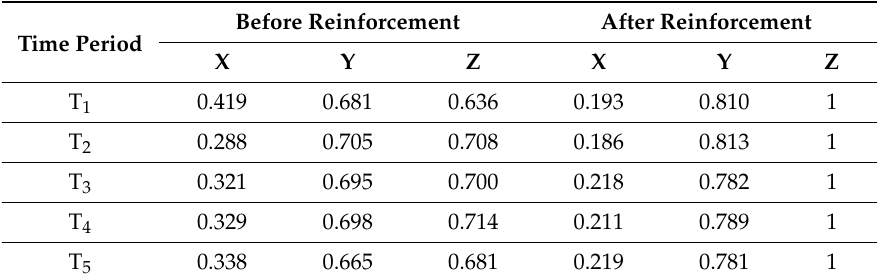
Table 14. The distance between the IVIFSs and the ideal solution before and after